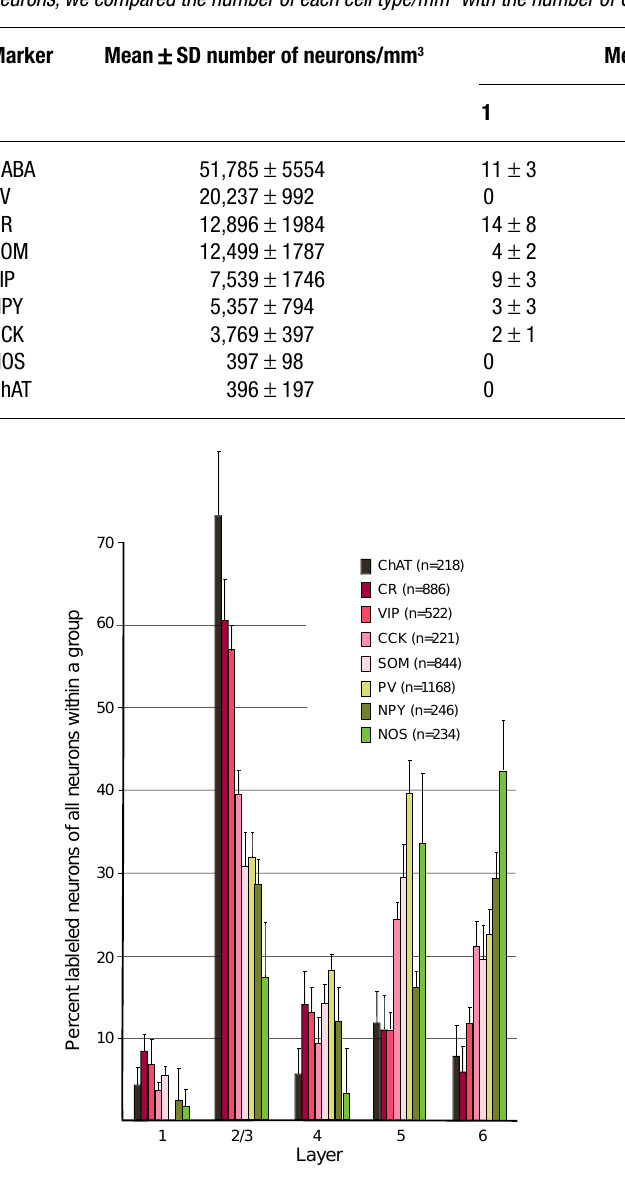
Figure 2. Laminar distribution of interneuron markers. Laminar distribu- tion of PV, CR, SOM, VIP, NPY, CCK, NOS and ChAT immunolabeled neurons in adult mouse primary visual cortex. Y-axis represents mean ± SEM percent of all neurons labeled with the same antibody.